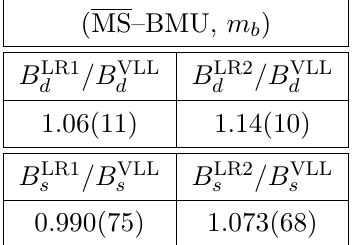
Table 11 . Bag parameters taken from [42] [Fermilab/MILC Collaboration, 2016] and adjusted to Buras et al. operator